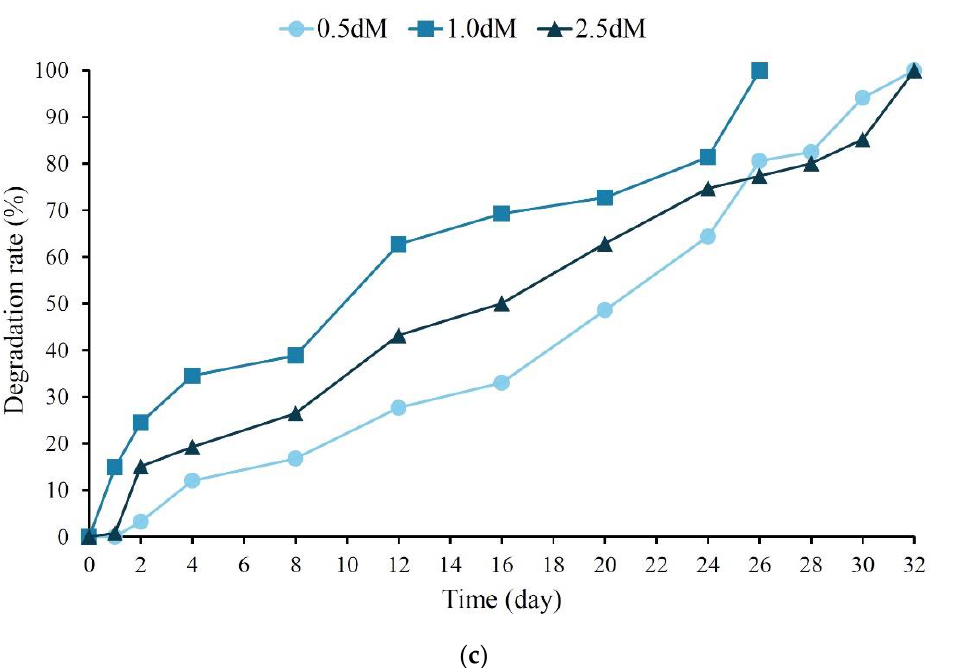
Figure 3. ( a ) FTIR spectra of raw materials, crosslinker, and microspheres modified with different concentrations of DAP. ( b ) Fixation of amine groups on microspheres modified with different concentrations of DAP to evaluate the degree of crosslinking ( n = 3, p > 0.05). ( c ) Weight loss of DAP-modified microspheres with different concentrations soaked in PBS for 32 days ( n = 3).